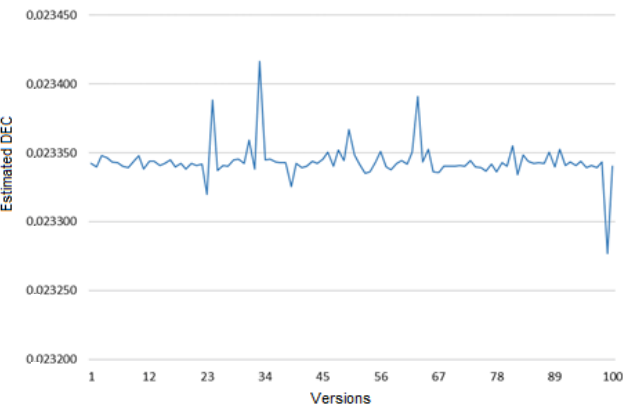
Figure 10. Estimated final DEC values.